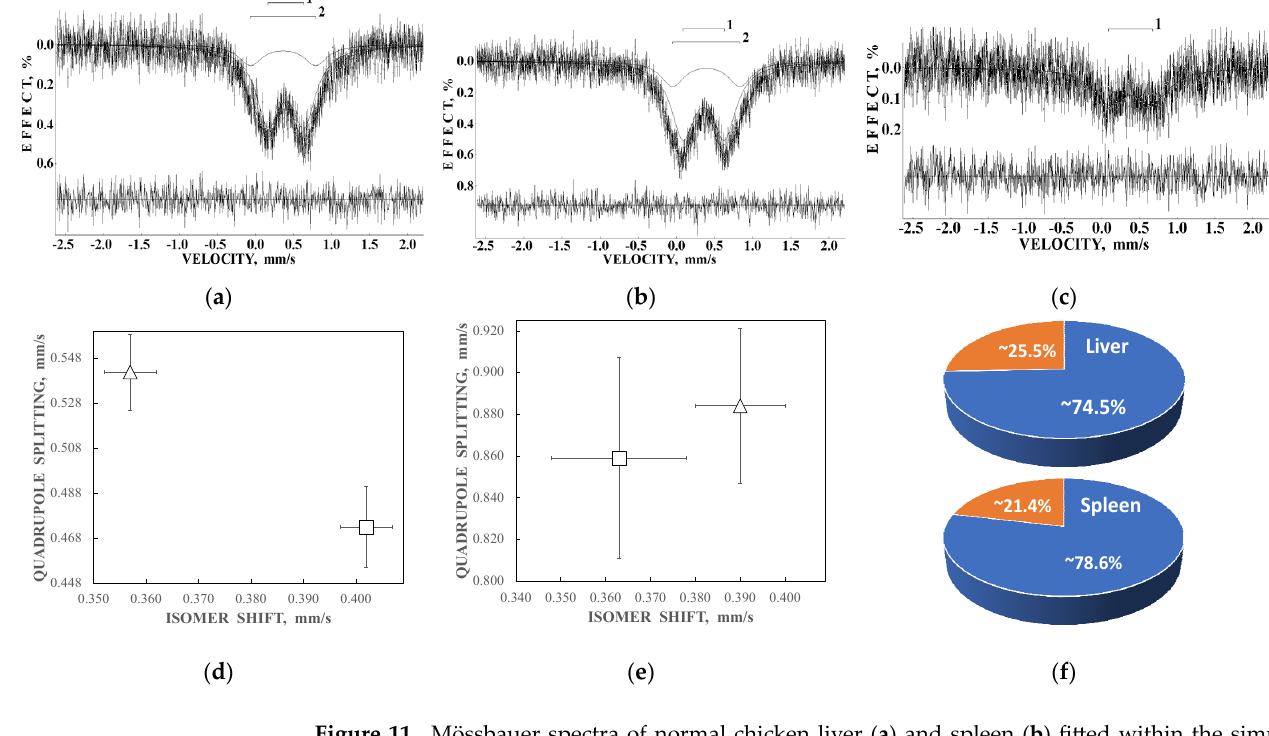
Figure 11. Mössbauer spectra of normal chicken liver ( a ) and spleen ( b ) fitted within the simple heterogeneous model for the ferritin‑like iron cores using two doublets 1 and 2, and lymphoid lymphoma chicken spleen ( c ) roughly fitted using one quadrupole doublet. The differential spectra are shown on the bottom (adapted from Ref. [53] with permission from Elsevier: Journal of Molecular Structure, Vol. 924–926, Oshtrakh M.I., Semionkin V.A., Milder O.B., Novikov E.G., “Mössbauer spectroscopy with high velocity resolution: new possibilities in biomedical research”, 20–26, ©2009); plots of the Mössbauer hyperfine parameters for doublet 1 ( d ) and doublet 2 ( e ), where □ is normal spleen, △ is normal liver; and comparison of the relative areas of doublet 1 ( ■ ) and doublet 2 ( ■ ) in the Mössbauer spectra of normal chicken liver and spleen ( f